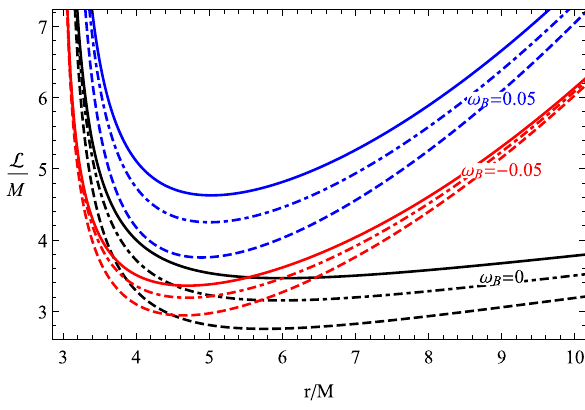
Fig. 6 Radial dependence of the specific angular momentum. Solid, dashed and dot-dashed lines correspond to the values of the conformal parameters ( L , N ) = ( 0 , 3 ) , ( 1 , 3 ) , and ( 1 , 1 ) , respectively. Blue, red and black lines correspond to positive, negative, and vanishing charge of the particle, respectively